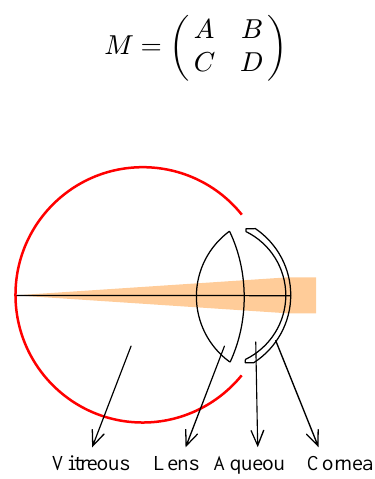
Fig. 4. The four-surface schematic eye model.